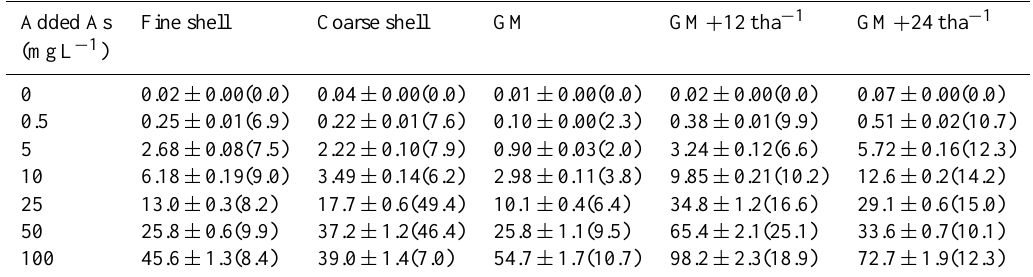
Table 2. Desorption results (average ± standard deviation, in mgkg − 1 , with percentage values between brackets) corresponding to fine and coarse mussel shell and to the unamended and shell-amended (12 and 24tha − 1 ) granitic material.